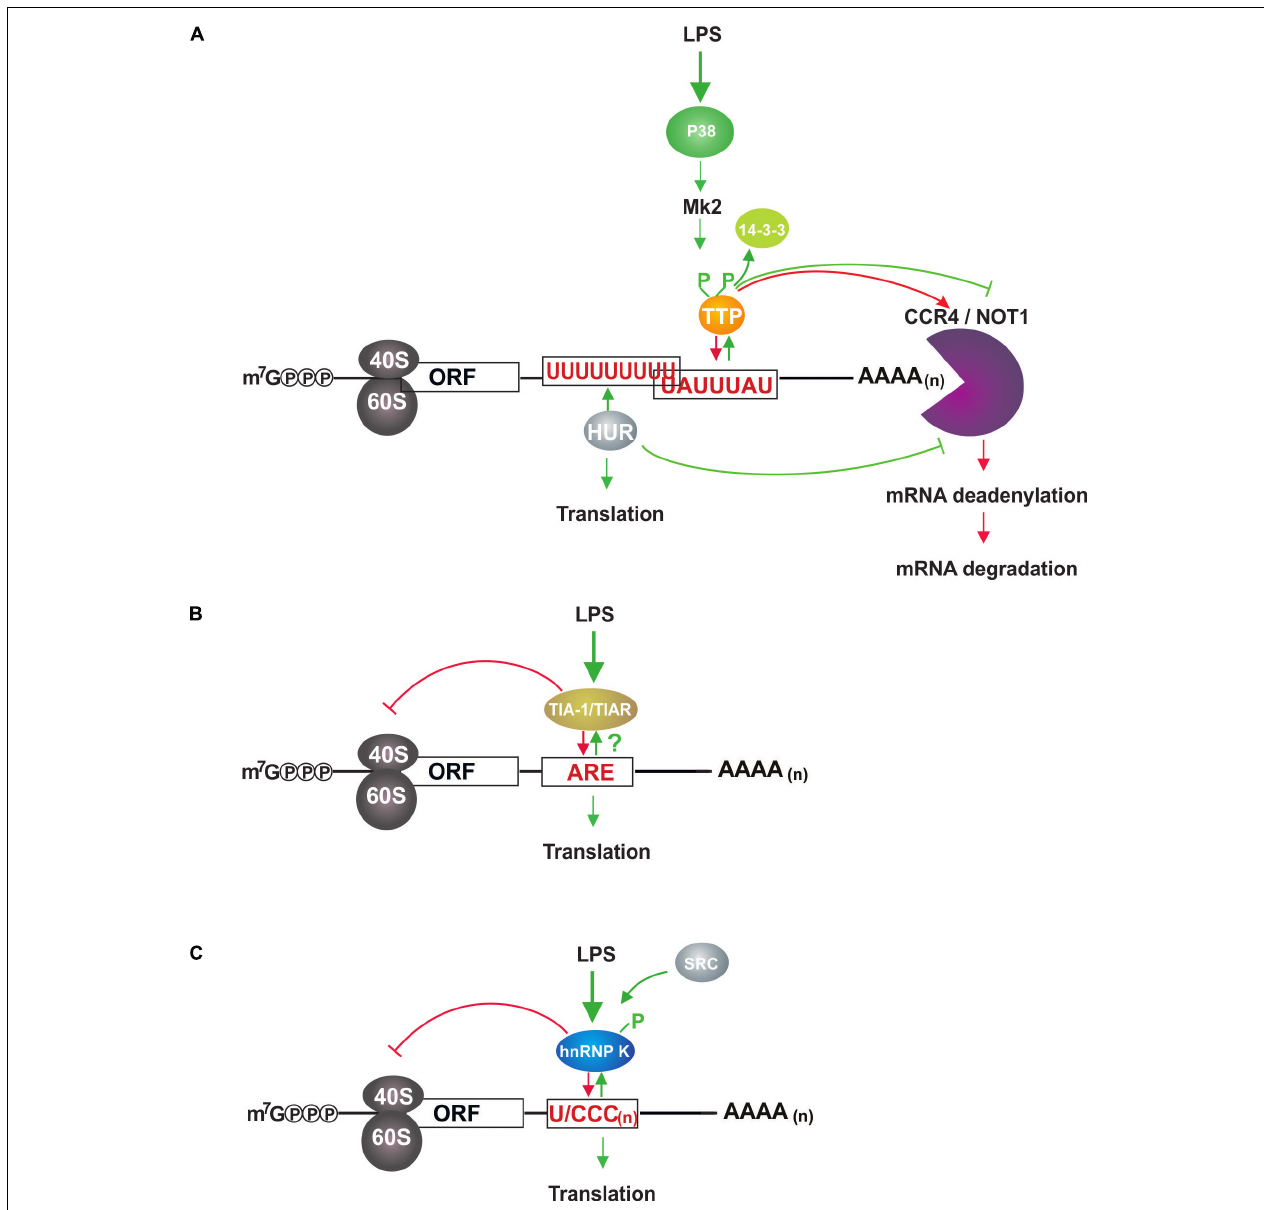
FIGURE 1 | LPS induced impact of TTP, HUR, TIAR, and hnRNP K on mRNAs in macrophages. (A) TTP and HUR interact with U-rich elements in the 3 (cid:48) UTR of target mRNAs and regulate their stability and translation (Stoecklin et al., 2008; Tiedje et al., 2012, 2016; Sedlyarov et al., 2016). In non-induced cells bound TTP recruits the CCR4/NOT1 complex, which initiates 3 (cid:48) UTR deadenylation and 3 (cid:48) to 5 (cid:48) mRNA decay. LPS induced TLR4 signaling activates MK2, which phosphorylates TTP leading to its sequestration by 14-3-3 proteins and subsequent abolition of deadenylation complex association. Following T 118 phosphorylation by MK2 HUR accumulates in the cytoplasm where it mediates mRNA stabilization, disables decay complex formation and enhances translation. By controlling mRNA decay, TTP curtails the synthesis of inflammation related proteins in non-induced macrophages, and regulates their balanced expression in response to LPS conjointly with